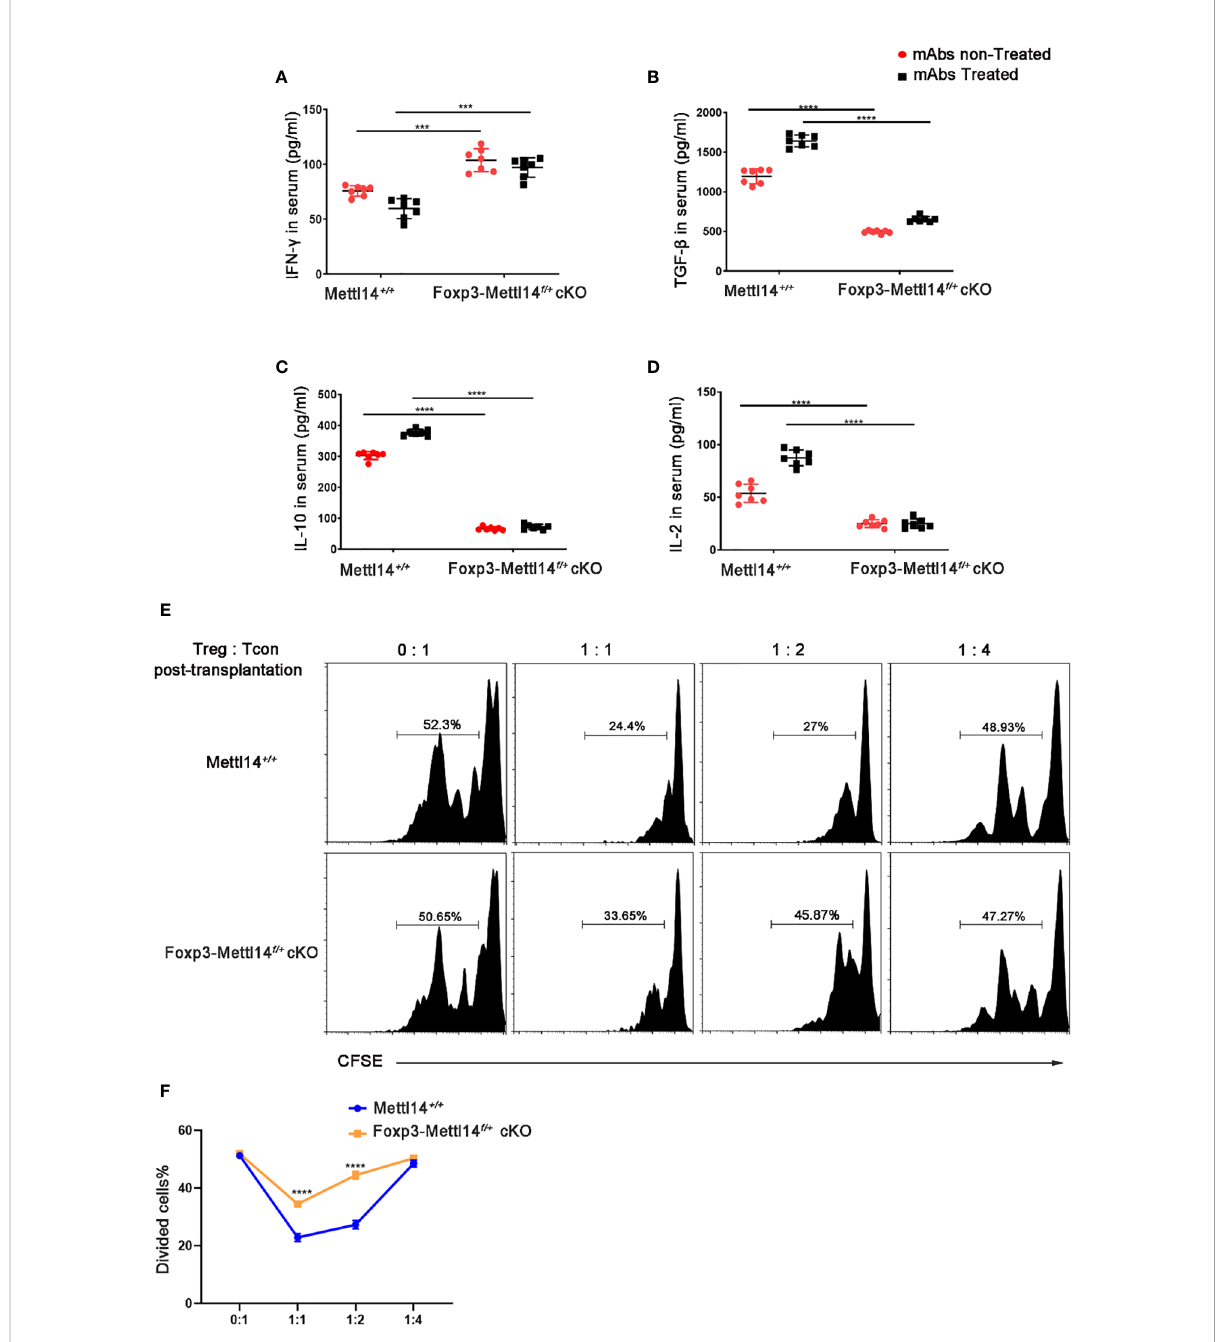
FIGURE 4 METTL14 de fi ciency Treg cells resulted in the loss of suppressive function after transplantation. (A – D) Serum was collected on day 7 after transplantation and cytokine levels were measured using ELISA assay. In the presence or absence of mAbs treatment, the scatter plots show the mean serum cytokine concentration in picograms per milliliter of IFN- g (A) , TGF- b (B) , IL-10 (C) and IL-2 (D) from serum in Foxp3-Mettl14f/+ cKO mice and littermate controls (n=7). (E) The islets were isolated from BALB/c mice and transplanted them under the kidney capsule of littermate controls or Foxp3-Mettl14f/+ cKO mice with STZ-induced diabetes. These mice were treated with mAbs as described above. Treg cells were isolated on day 7 post-transplantation which were co-cultured with CFSE-labeled CD4+ naïve T cells from C57BL/6J mice, in round- bottom 96-well plates containing anti-CD3 (3 m g/ml) and anti-CD28 (5 m g/ml) monoclonal antibodies, at various ratios for 5 days. The suppressive effect on T cell expansion was detected using fl ow cytometry. (F) The suppressive function of Treg cells was quanti fi ed. The data are presented as the means ± SD. The data in (A-D) depict the mean values measured from seven separate experiments, while the data in (D) are representative of at least three independent experiments. The statistical analysis was performed with an unpaired Student ’ s t-test (two-